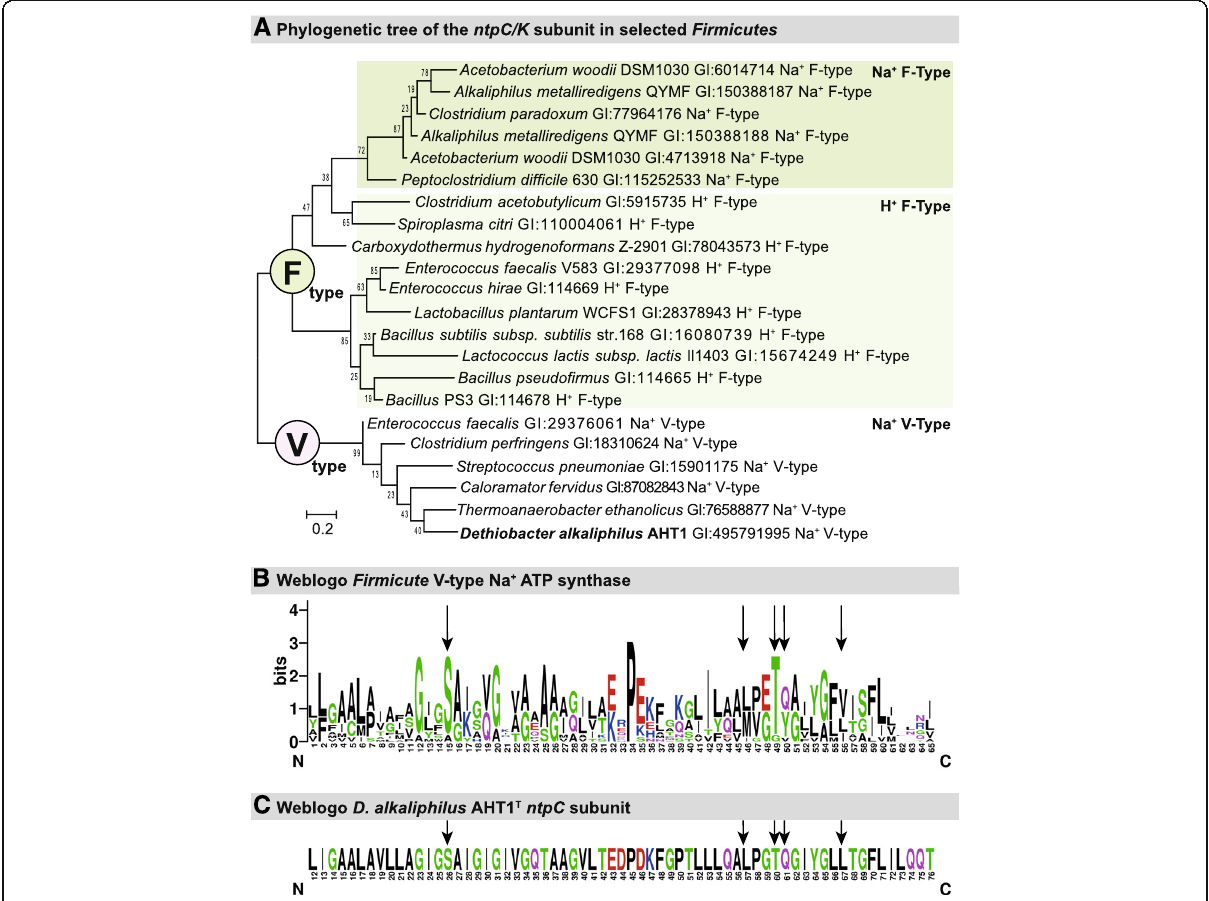
Fig. 6 a Phylogeny of the F- vs. V-type ATPase within the Firmicutes . Numbers on the tree nodes indicate bootstrap values (1000 replicates). Scale bar indicates 0.2% sequence difference. b Weblogo of conserved region within the ntpC/K Firmicu subunit [42, 43]. c Weblogo of aligned D. alkaliphilus AHT1 T subunit ntpC (DealDRAFT_1683) where conserved Na + binding regions (in B and C) are indicated with black